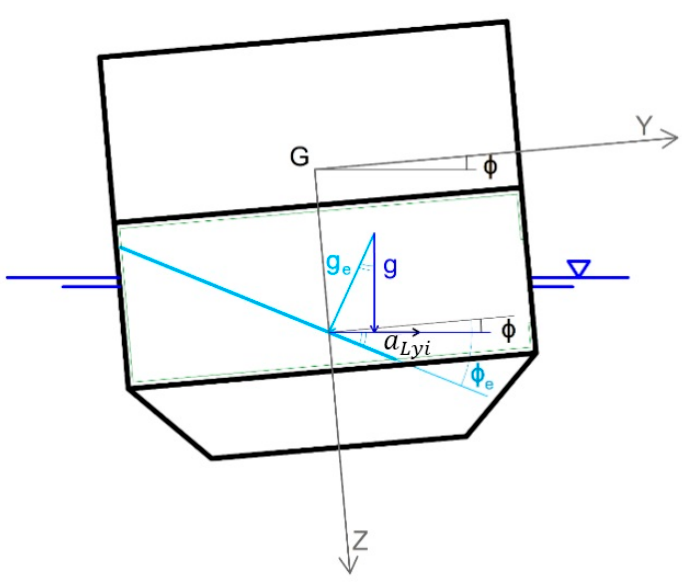
Figure 1. Sketch of the free surface inclination assumption.